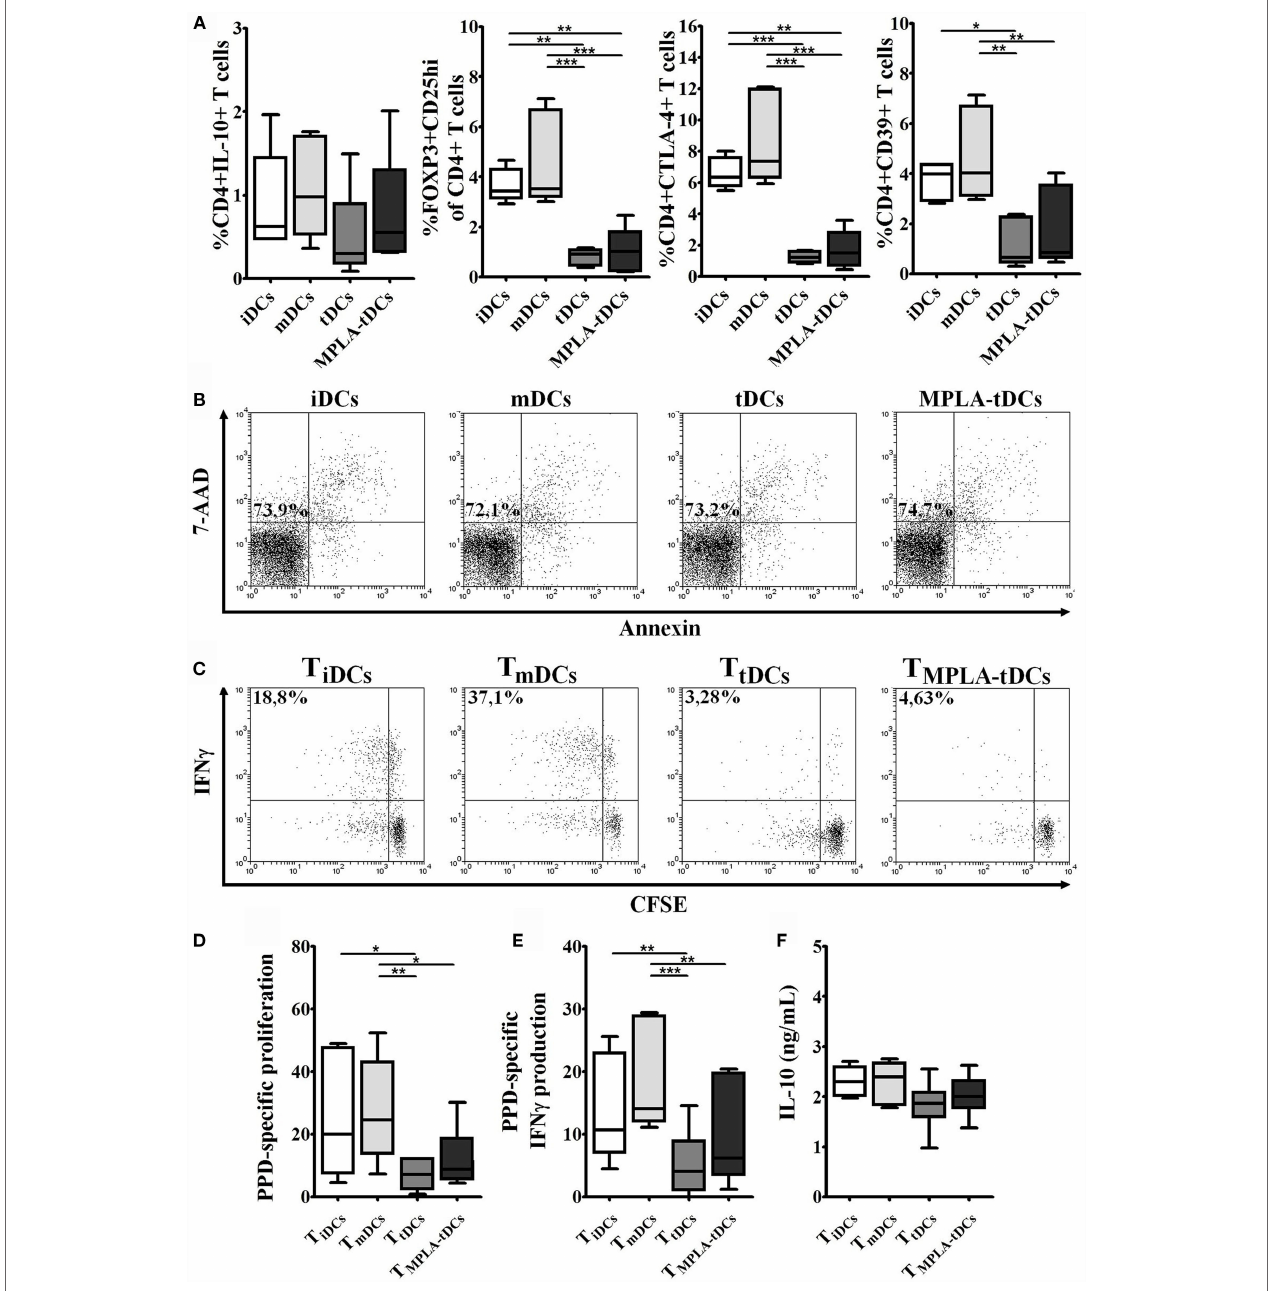
FigUre 4 | naive cD4 + T cells primed by MPla-tDcs do not exhibit a regulatory phenotype and become hyporesponsive to restimulation . MPLA-tDCs ability to induce phenotypic regulatory properties on naive CD4 + T cells after co-culturing was evaluated. (a) Expression of IL-10, FOXP3 in combination to CD25, CTLA-4, and CD39 was evaluated by flow cytometry. Graphic analyses of MFI measurements are expressed as box-and-whiskers plot from minimum to maximum values ( n = 5). Statistical differences were calculated using Friedman test (for non-parametric data) or one-way ANOVA (for normally distributed data) followed by Duns or Tukey post-test, respectively (* P < 0.05; ** P < 0.01; *** P < 0.001). (B) Representative dot plots of cell viability measured after 6 days of co-culture and expressed as the percentage of annexin-V and 7-AAD-negative cells are shown. For restimulation assays, naive CD4 + T cells were primed with PPD-loaded DC subsets and then were recovered, washed, labeled with CFSE, and restimulated with unpulsed or PPD-pulsed mDCs. Data were normalized by subtracting values of unpulsed conditions to antigen-specific conditions. (c) Representative dot plots of IFN- γ expression from six independent experiments are shown. (D) Proliferation of restimulated primed-CD4 + T cells was determined by CFSE dilution through flow cytometry, and graphic representation of normalized data of the percentage of CFSE low in CD4 + T cells is shown. (e) IFN- γ expression was detected intracellularly and analyzed by flow cytometry. Graphic representation of normalized data of the percentage of IFN- γ producing proliferating CD4 + T cells (CFSE low ) is shown. (F) IL-10 secretion levels from mDC/primed-T cell co-culture supernatants were measured using ELISA. For (D–F) , statistical differences were calculated using one-way ANOVA followed by Tukey post-test (* P < 0.05; ** P < 0.01; *** P <